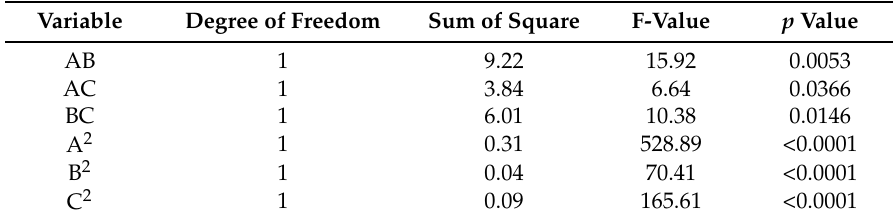
Table 8. Estimated regression model of the relationship between yield of BA and independent variables (A, B,